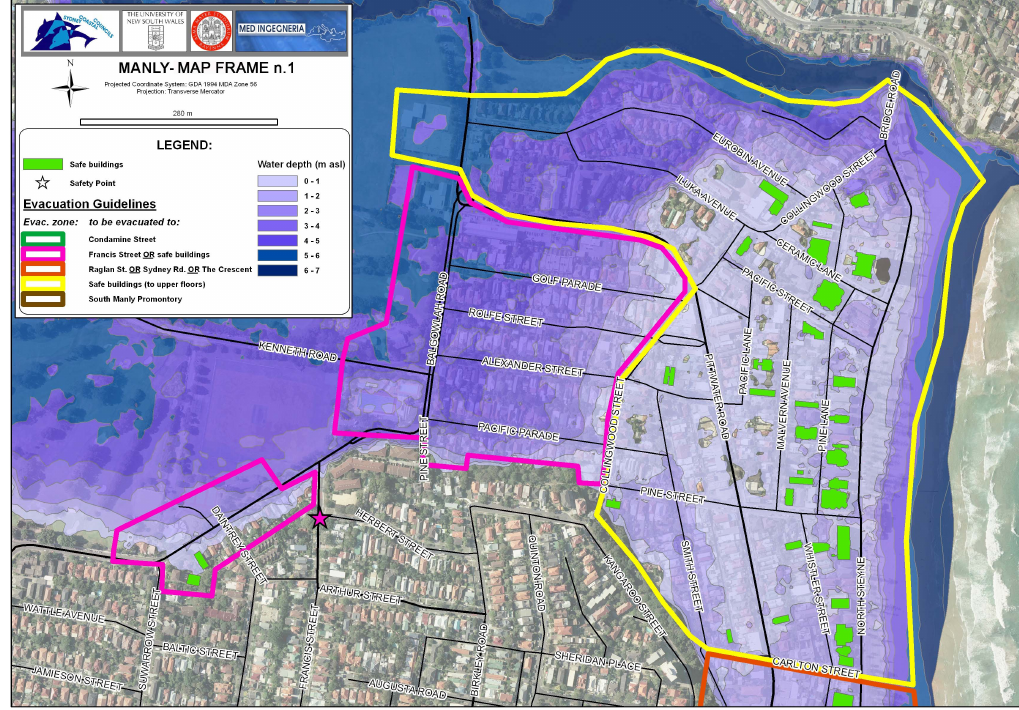
Fig. 5. “Draft” evacuation map for the northern part of Manly (map frame n. 1). The star indicates the location of the identified evacuation point. Safe buildings for vertical evacuation are colored in